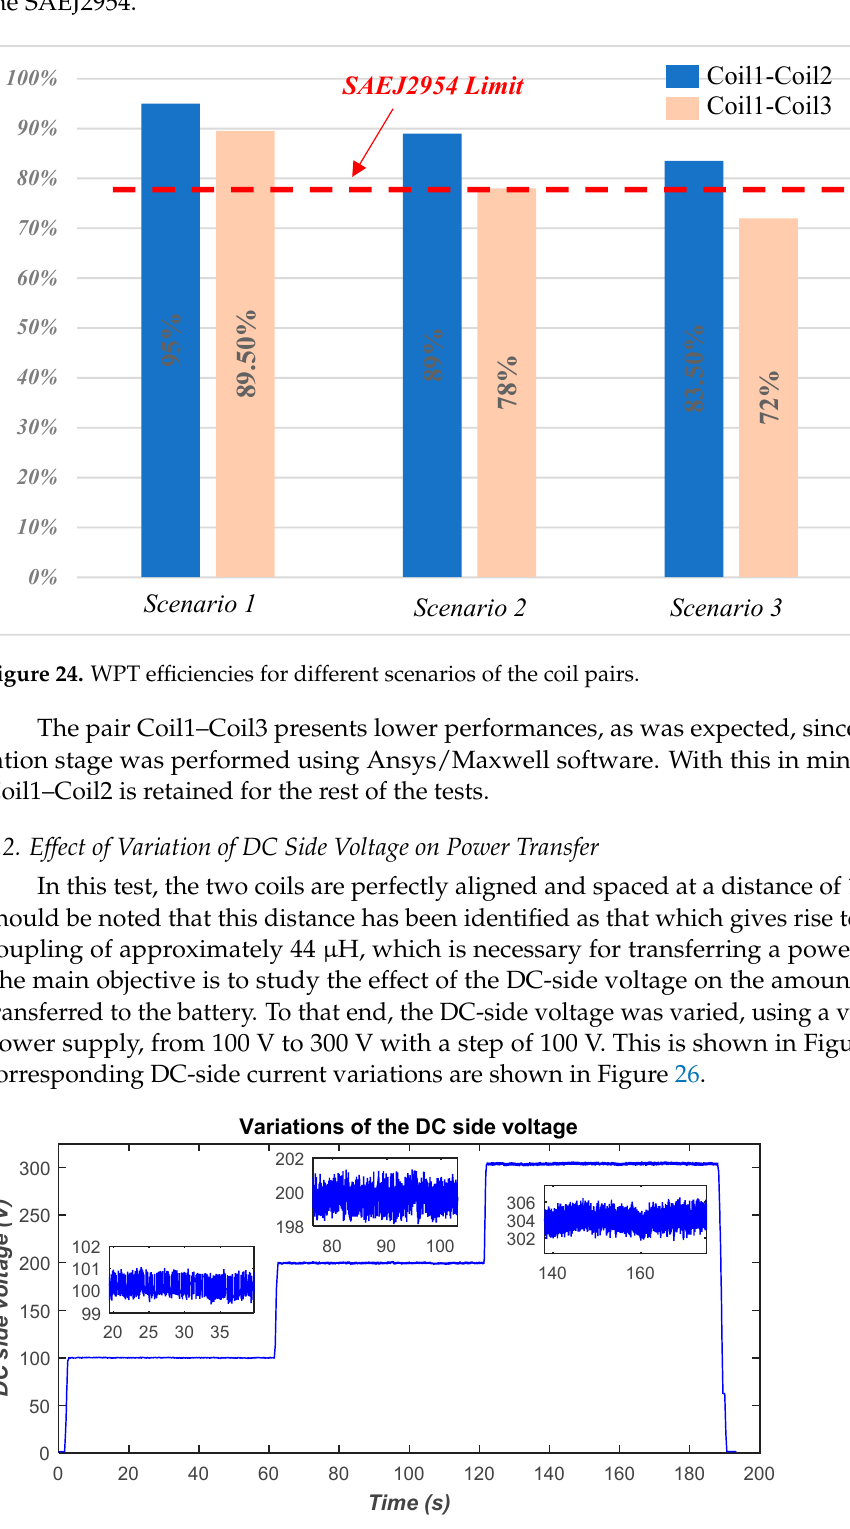
Figure 25. DC-side voltage variations.